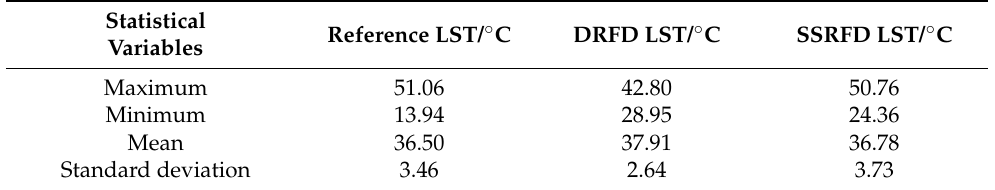
Table 3. Statistical values of LST downscaled from DRFD, SSRFD methods and Landsat reference LST data at a 30-m